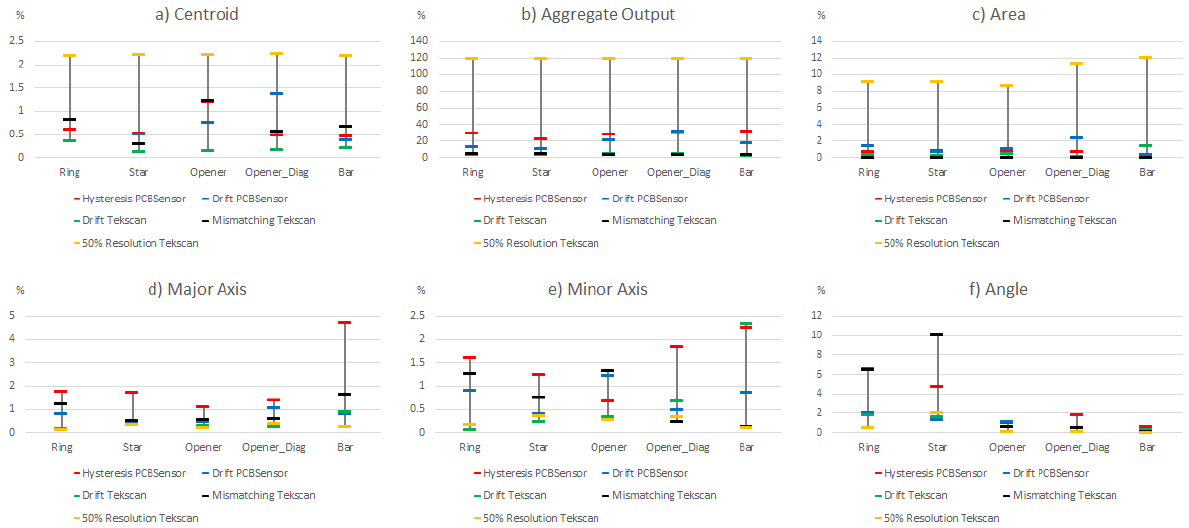
Figure 14. Comparison of the influence of different non idealities on the parameters of Table 4 (percentile 80%).